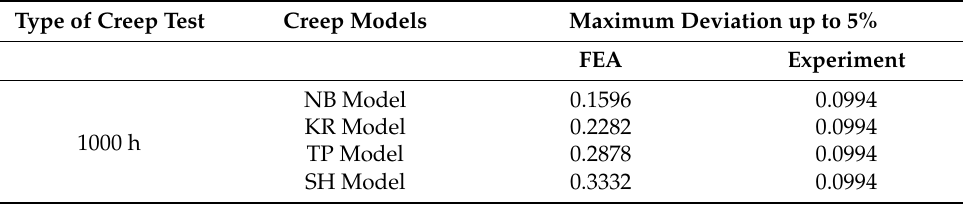
Table 5. Maximum percentage deviation between FE and creep experiment results for the models.